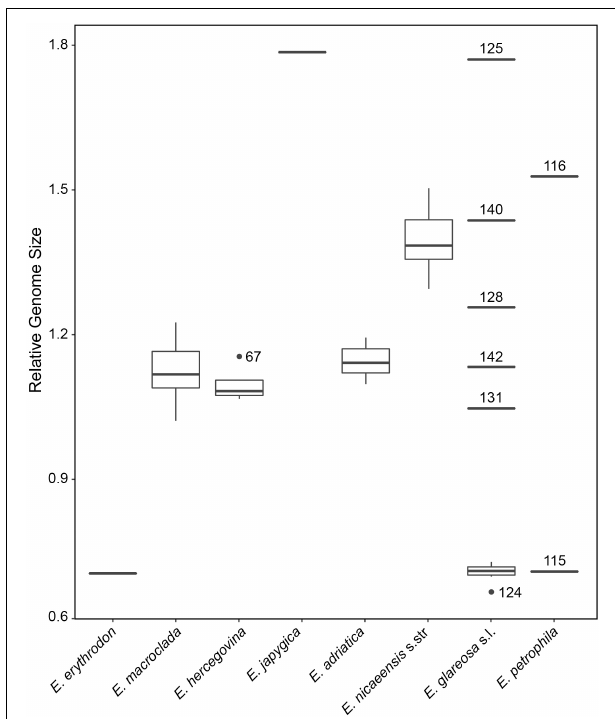
FIGURE 6 | Relative genome size (RGS) variation in the Euphorbia nicaeensis alliance. Outliers putatively belonging to the same ploidy level as the majority of the samples are presented as dots, whereas putatively ploidy-divergent outliers are presented as lines, including their population numbers, which correspond to Supplementary Figure 1 and Supplementary Table 1